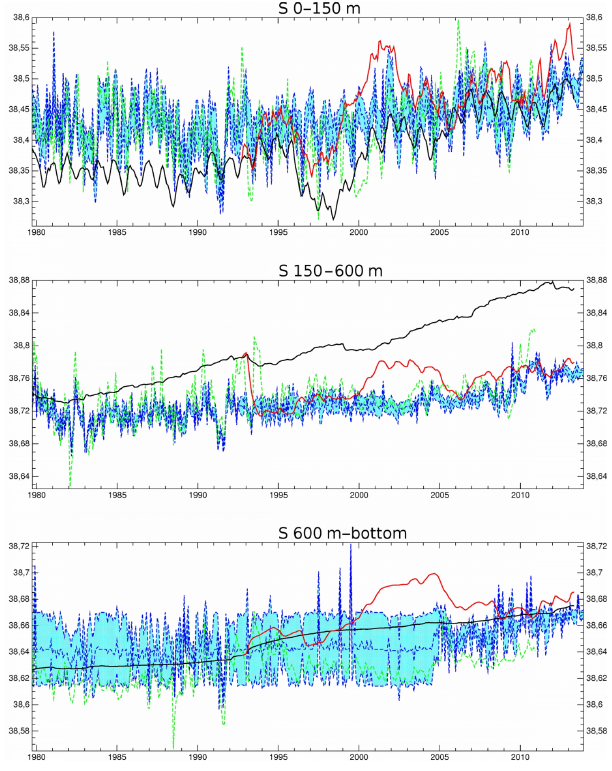
Figure 9. Same as Fig. 8 but for integrated salt content (expressed as mean salinity in